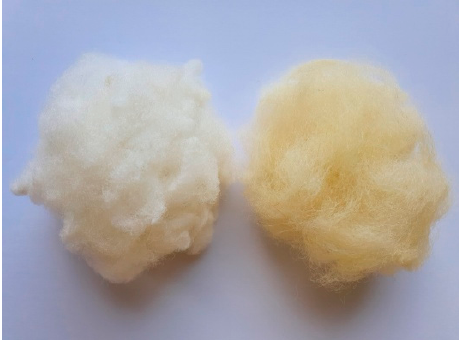
Figure 16. Photo of wool balls of the reference ( left ) and UV-aged ( right ) fibers.